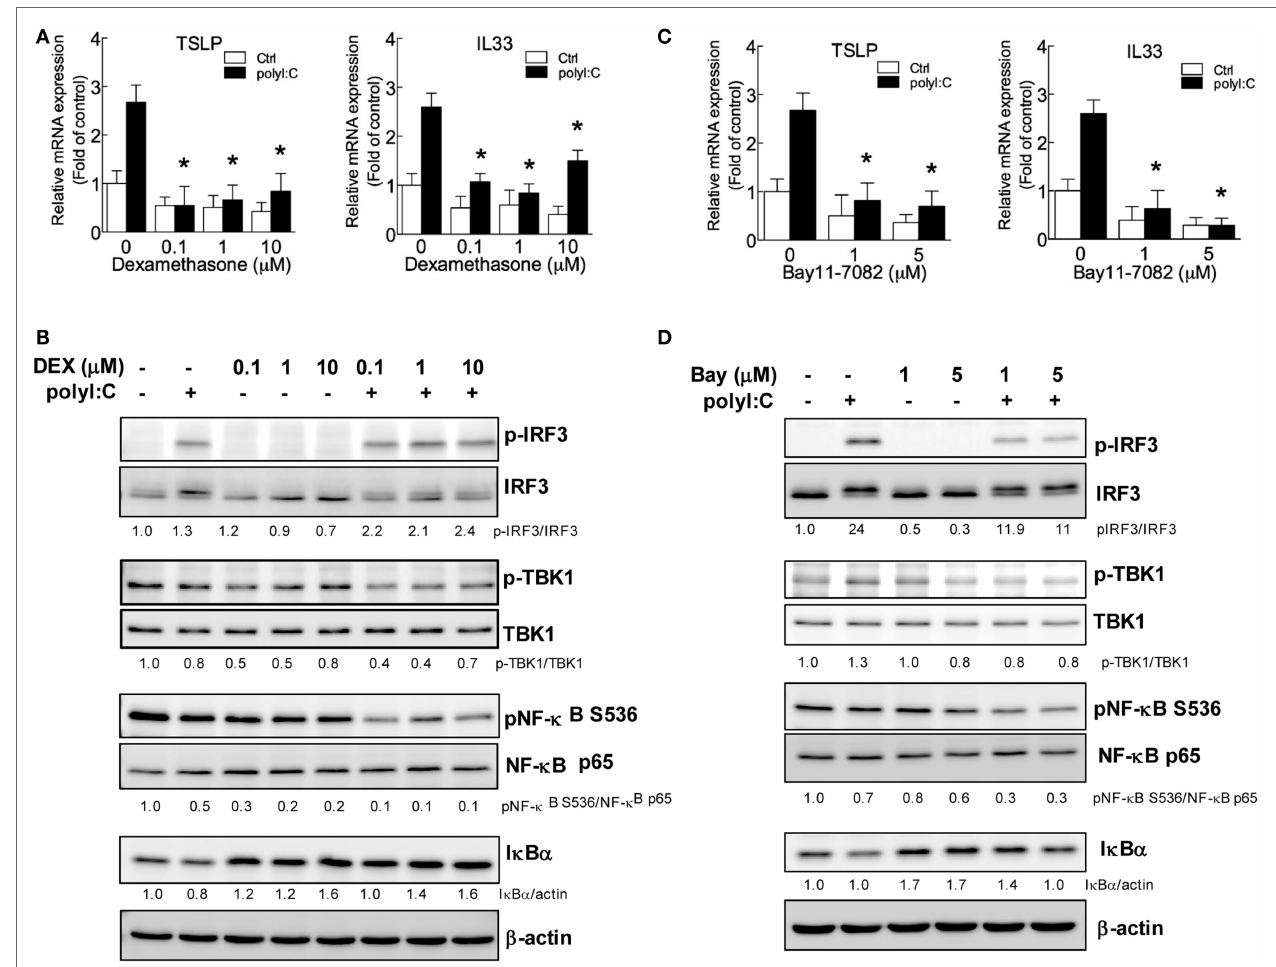
FigUre 3 | irF3 and nF- κ B inhibitors suppress polyi:c-stimulated TslP and il33 expression . H292 cells were treated with NF- κ B or IRF3 inhibitors dexamethasone (0.1, 1, and 10 μ M) or Bay 11-7082 (1 and 5 μ M) for 2 h, then challenged with polyI:C (2.5 μ g) for 3 h. (a,c) . The mRNA expression of TSLP and IL33 was measured by RT-qPCR. Data are mean ± SD from three independent experiments. * P < 0.05 compared to untreated controls with polyI:C stimulation. (B,D) Immunoblotting analysis with the indicated antibodies. Data shown are representative of three different experiments. The proteins expression level was measured by density meter; the value is normalized to untreated